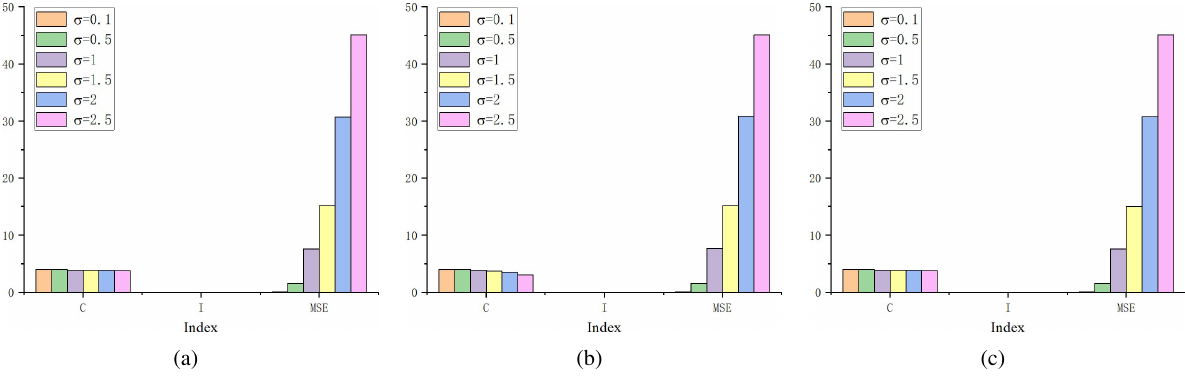
Fig. 4 Simulation results when N = 200, R = 10 and ρ = 0.1. (a) The result of ALASSO penalty function; (b) the result of LASSO penalty function; and (c) the result of SCAD penalty function. ALASSO, adaptive least absolute shrinkage and selection operator; LASSO, least absolute shrinkage and selection operator; SCAD, smoothly clipped absolute